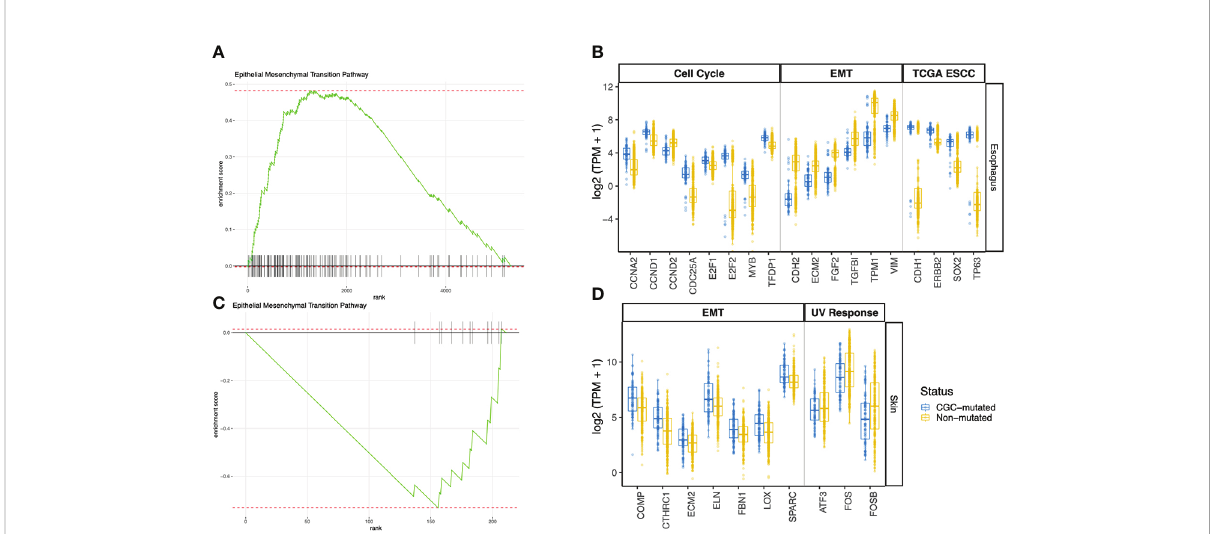
FIGURE 3 GSEA Pathway analysis using differentially expressed genes between CGC-m and non-mutated groups. (A, C) Shows GSEA enrichment of EMT pathway in esophagus and skin (B) Boxplots of gene expression (log2 TPM +1) between CGC-m and non-m cases for signi fi cantly differentially expressed genes (p-adjusted<= 0.01) genes implicated in the EMT pathway, cell cycle pathway and esophageal carcinomas previously reported by TCGA. (D) Boxplots of gene expression (log2 TPM +1) between CGC-m and non-m cases for signi fi cantly differentially expressed gens (p- adjusted<= 0.01) genes implicated in the EMT and UV response